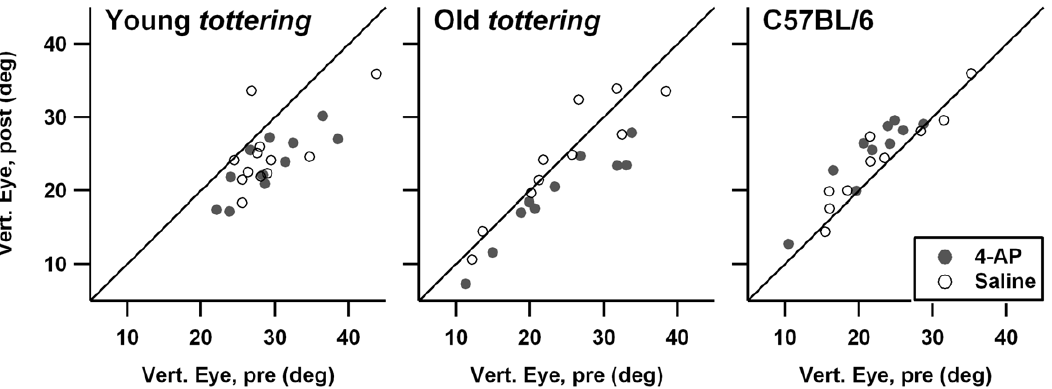
Figure 9. Comparison of resting vertical eye position before and after saline or 1.25 mg/kg 4-AP administration. Symbols and format are identical to Figure 1. Averaged drug and saline responses differed significantly in old tottering , but the difference may originate in an atypical response in the saline experiments.